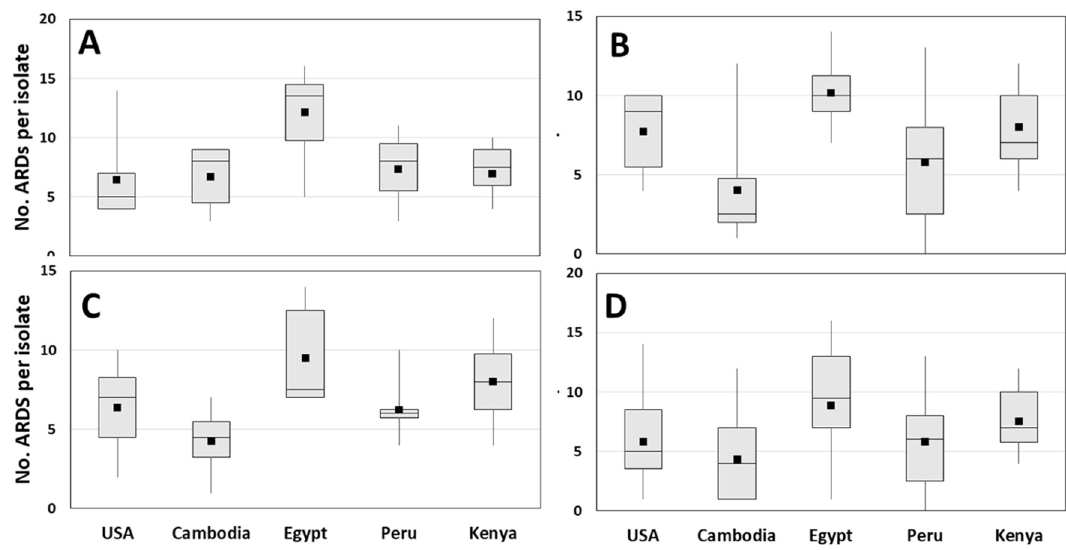
Figure 3. Box and whisker charts showing number of unique ARDs per isolate for ( A ) E. coli ; ( B ) Shigella spp.; ( C ) Salmonella ; ( D ) each population as a whole (including Campylobacter spp.). Black squares in each chart indicate mean values.